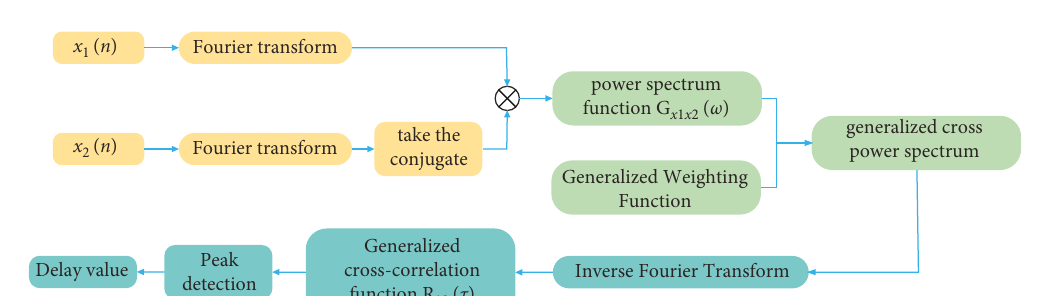
Figure 13: The principle block diagram of the generalized cross-correlation delay estimation